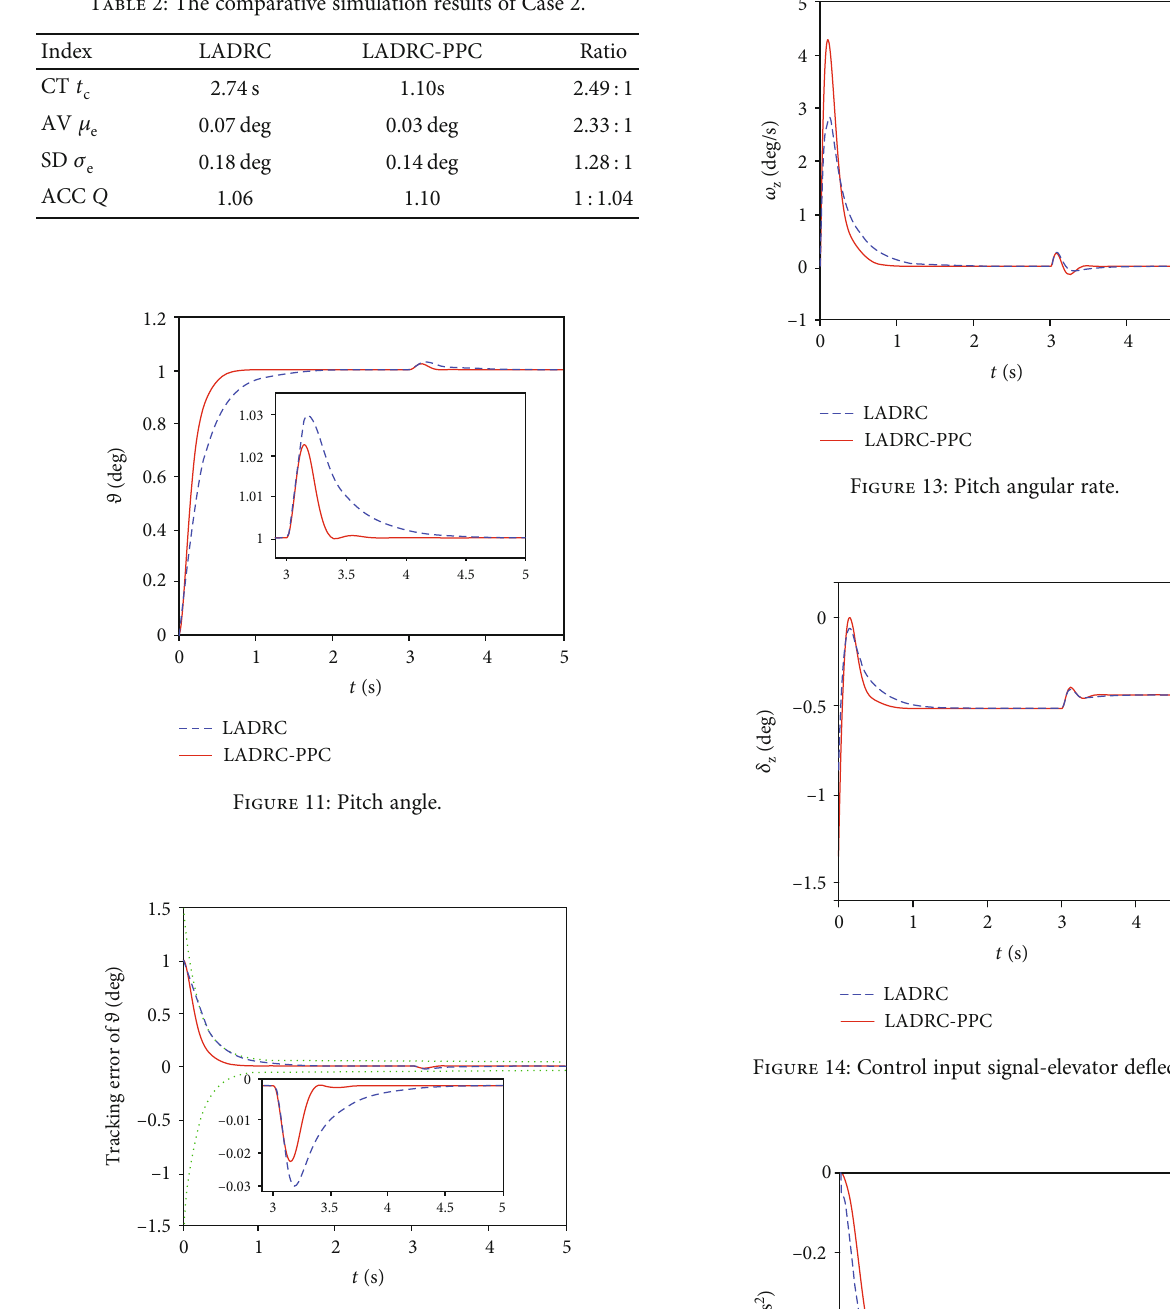
Table 2: The comparative simulation results of Case 2.